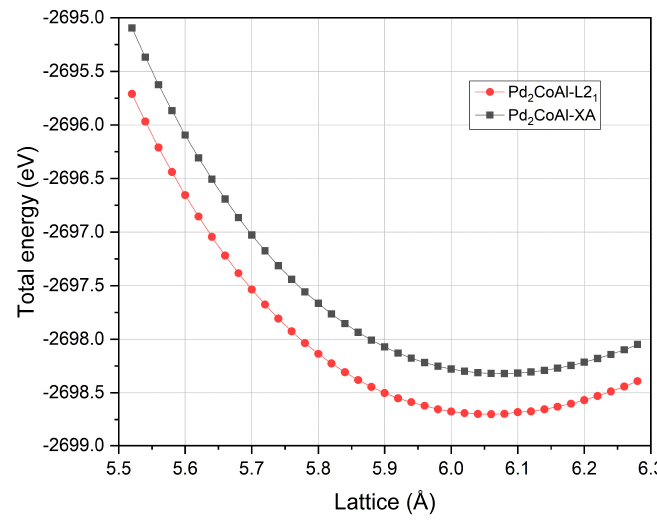
Figure 2. The calculated total energies of the full Heusler compound Pd 2 CoAl with di ff erent crystal structures under di ff erent lattice constants.